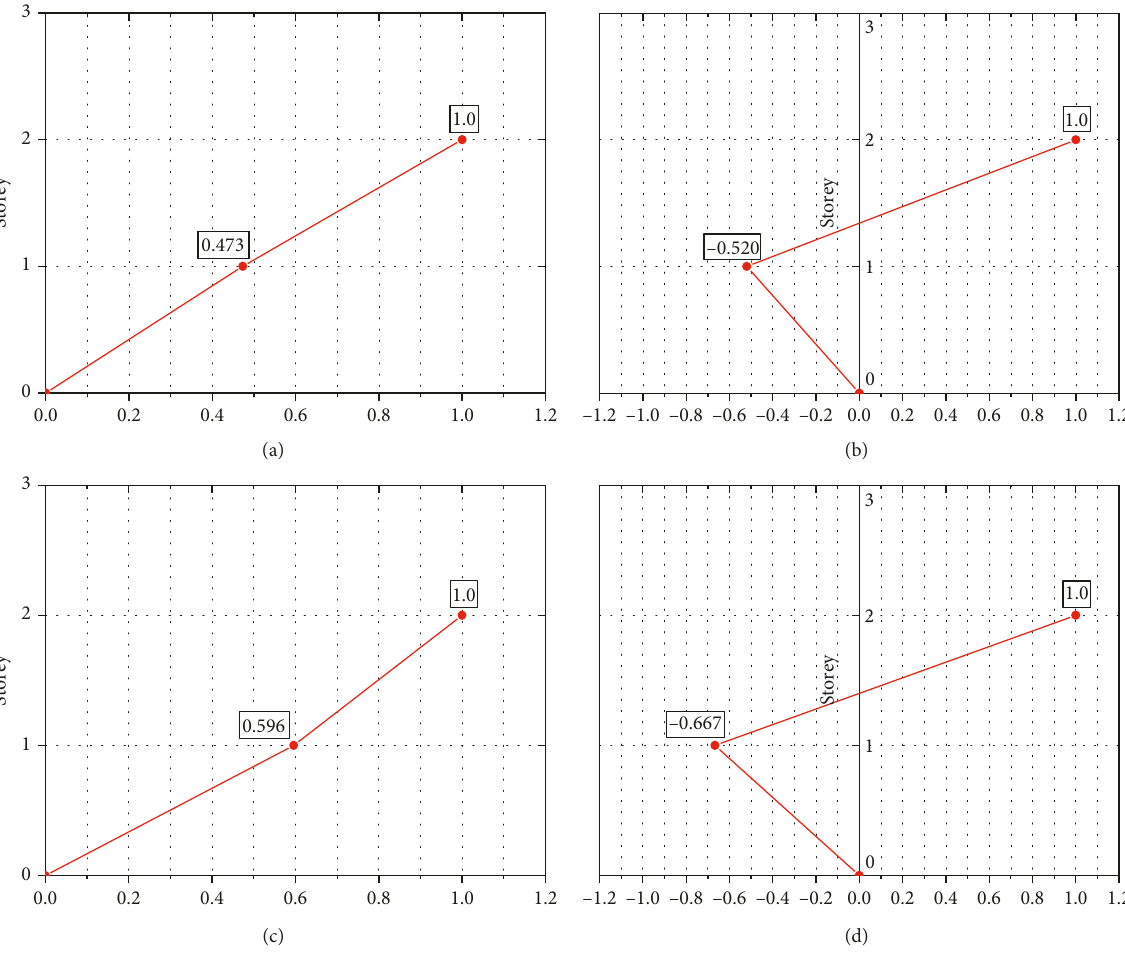
Figure 17: Vibration mode obtained with software uTekMa. (a) First order in X direction. (b) Second order in X direction. (c) First order in Y direction. (d) Second order in Y direction.